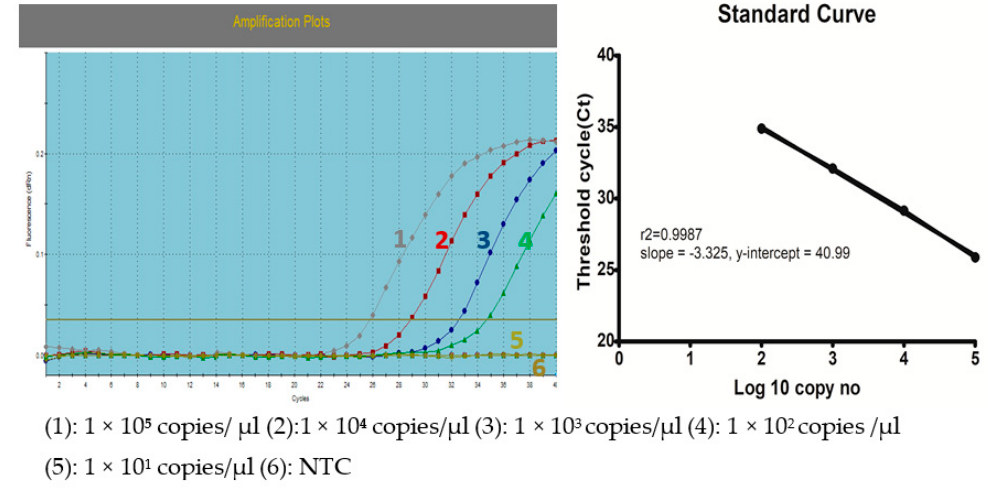
Figure A1. Amplification plot and Standard curve for quantitation of vvIBDV copy number by real-time PCR. Q-PCR performed on serial ten-fold dilution from 1.0 × 105 to 1 × 101 copies / µ l with NTC as control. Standard curve with Log10 copy number plotted as X-axis and Ct values on Y-axis. Slope = − 3.325; y-intercept = 40.99.